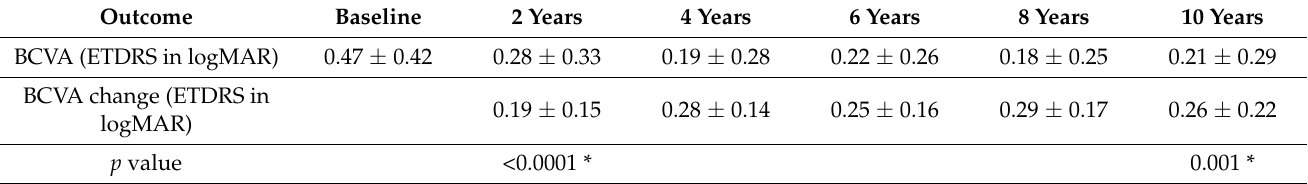
Table 3. Visual outcomes after IVB treatment for mCNV.